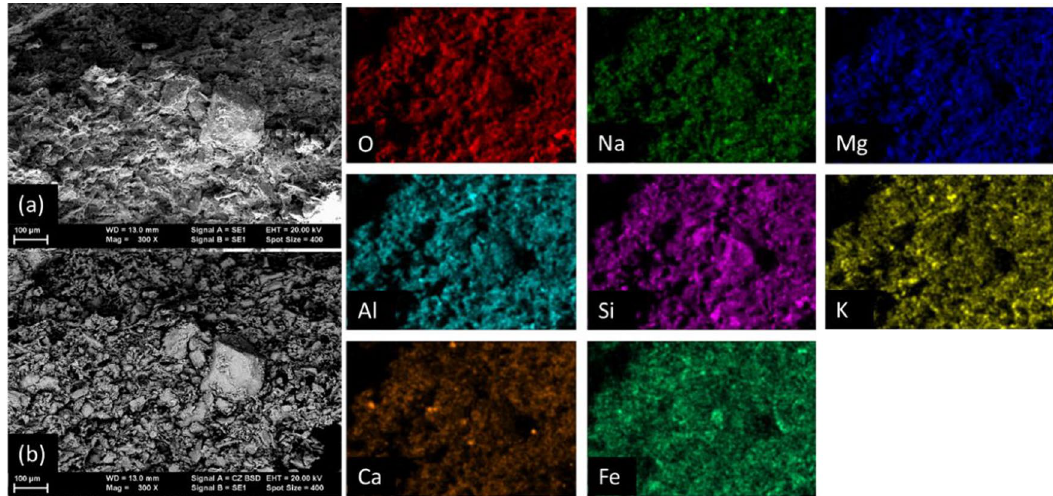
Figure 12. Electron microscopy images of the burnt brick B in secondary electron ( a ) and backscattered mode ( b ) and EDS maps of selected